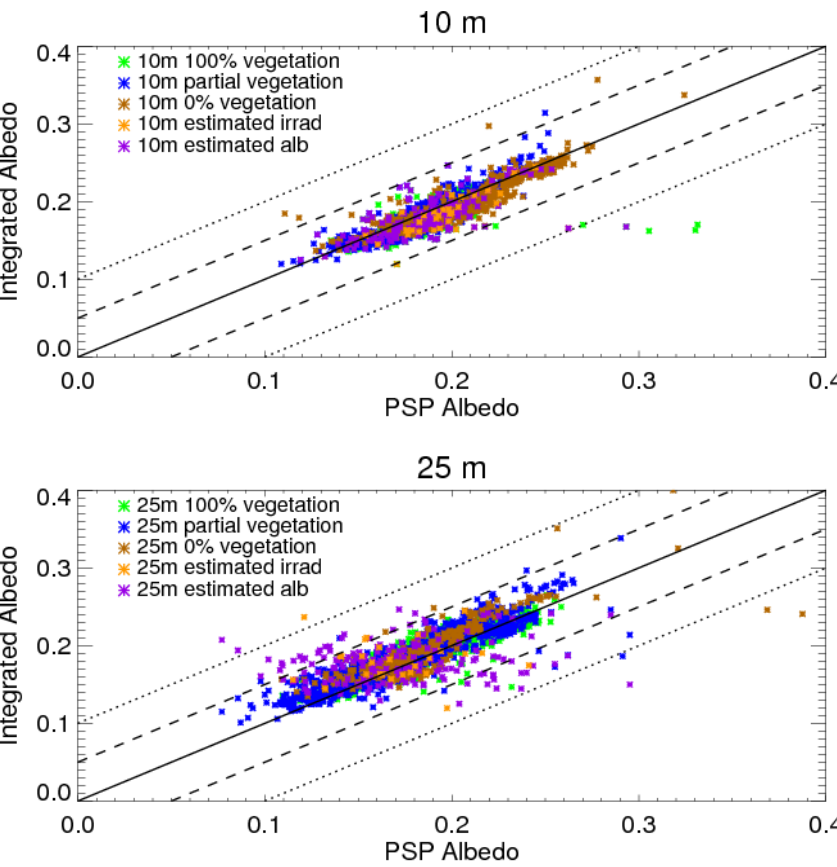
Fig. 9. Comparison of integrated spectral albedo to measured broadband albedo near noon for (top) 10 m tower measurements and (bottom) 25 m tower measurements. Surface type and mean, median, standard deviations of differences (measured-integrated) are given in the plots. Points for which irradiance values (orange) or albedo values (purple) are estimated are also indicated.